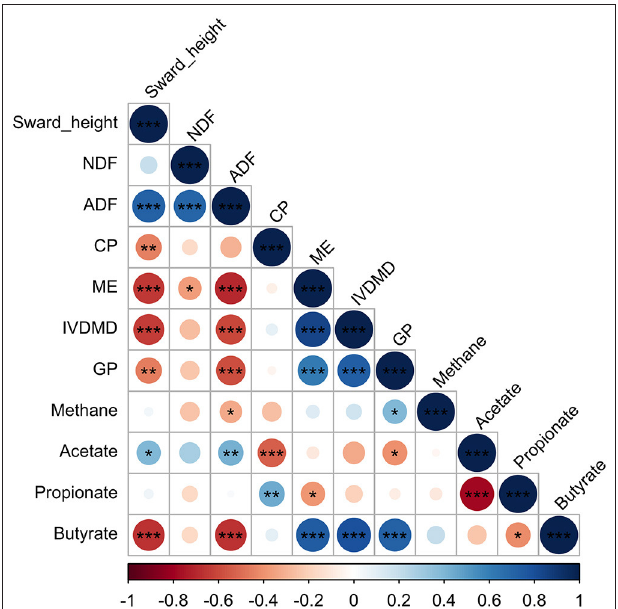
FIGURE 1 | Correlation plot between the sward height, nutritive value, and in vitro fermentation parameters at 48h of Kikuyu grass harvested at different sward heights ( n = 36). Positive and negative correlation coefficients are displayed in blue and brown scale, respectively. Sward_height, (cm); NDF, neutral detergent fiber (g/kg of DM); ADF, acid detergent (g/kg of DM), CP, crude protein (g/kg of DM); ME, metabolizable energy Mcal/kg of DM; IVDMD, in vitro dry matter digestibility (g); GP, Gas production (mL/ g DMi). DMi, dry matter incubated. Methane (total in vitro CH 4 production, ml), acetate, propionate, and butyrate (mol/100 mol). Significance level (*** p < 0.001, ** p < 0.01, and * p < 0.05).